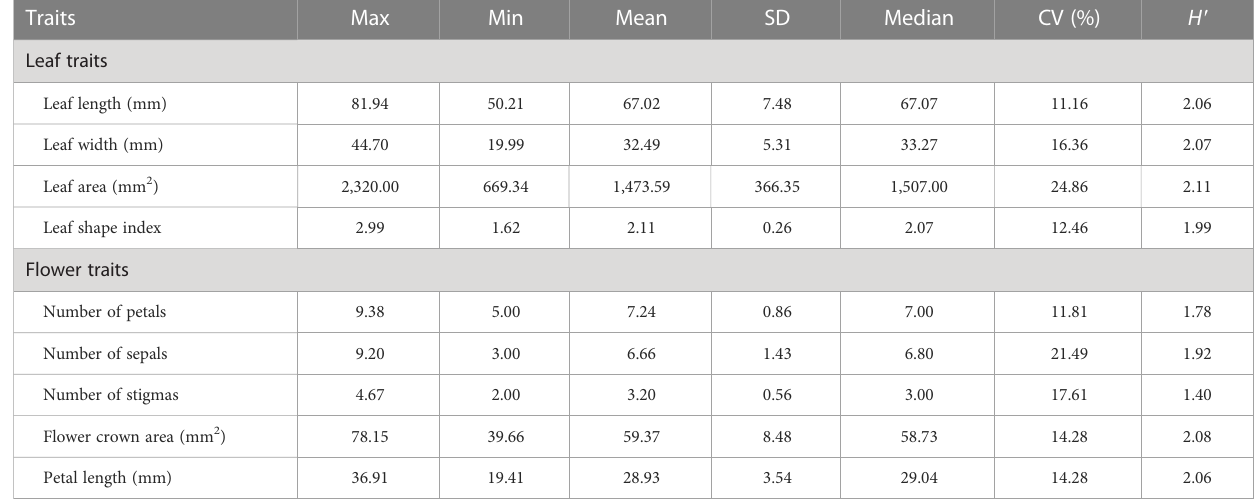
TABLE 2 Variability and genetic diversity of the quantitative traits in leaves and fl owers.